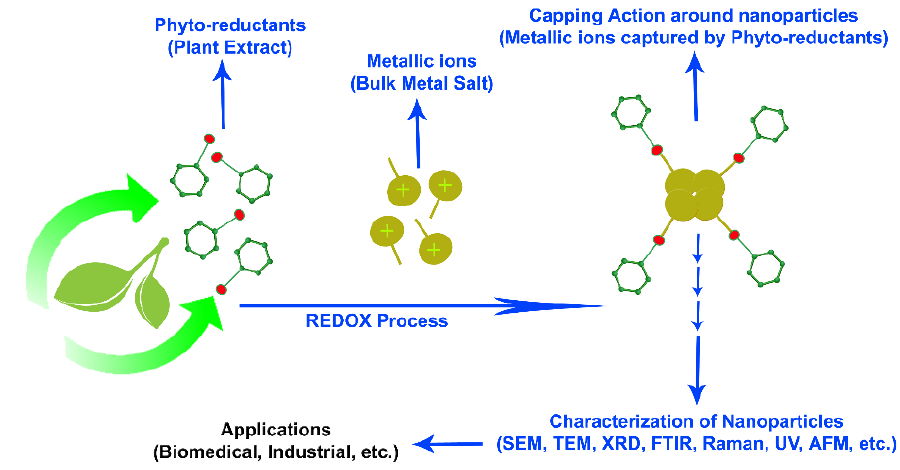
Figure 3. A scheme describing the mechanism of in vitro green synthesis of nanoparticles.